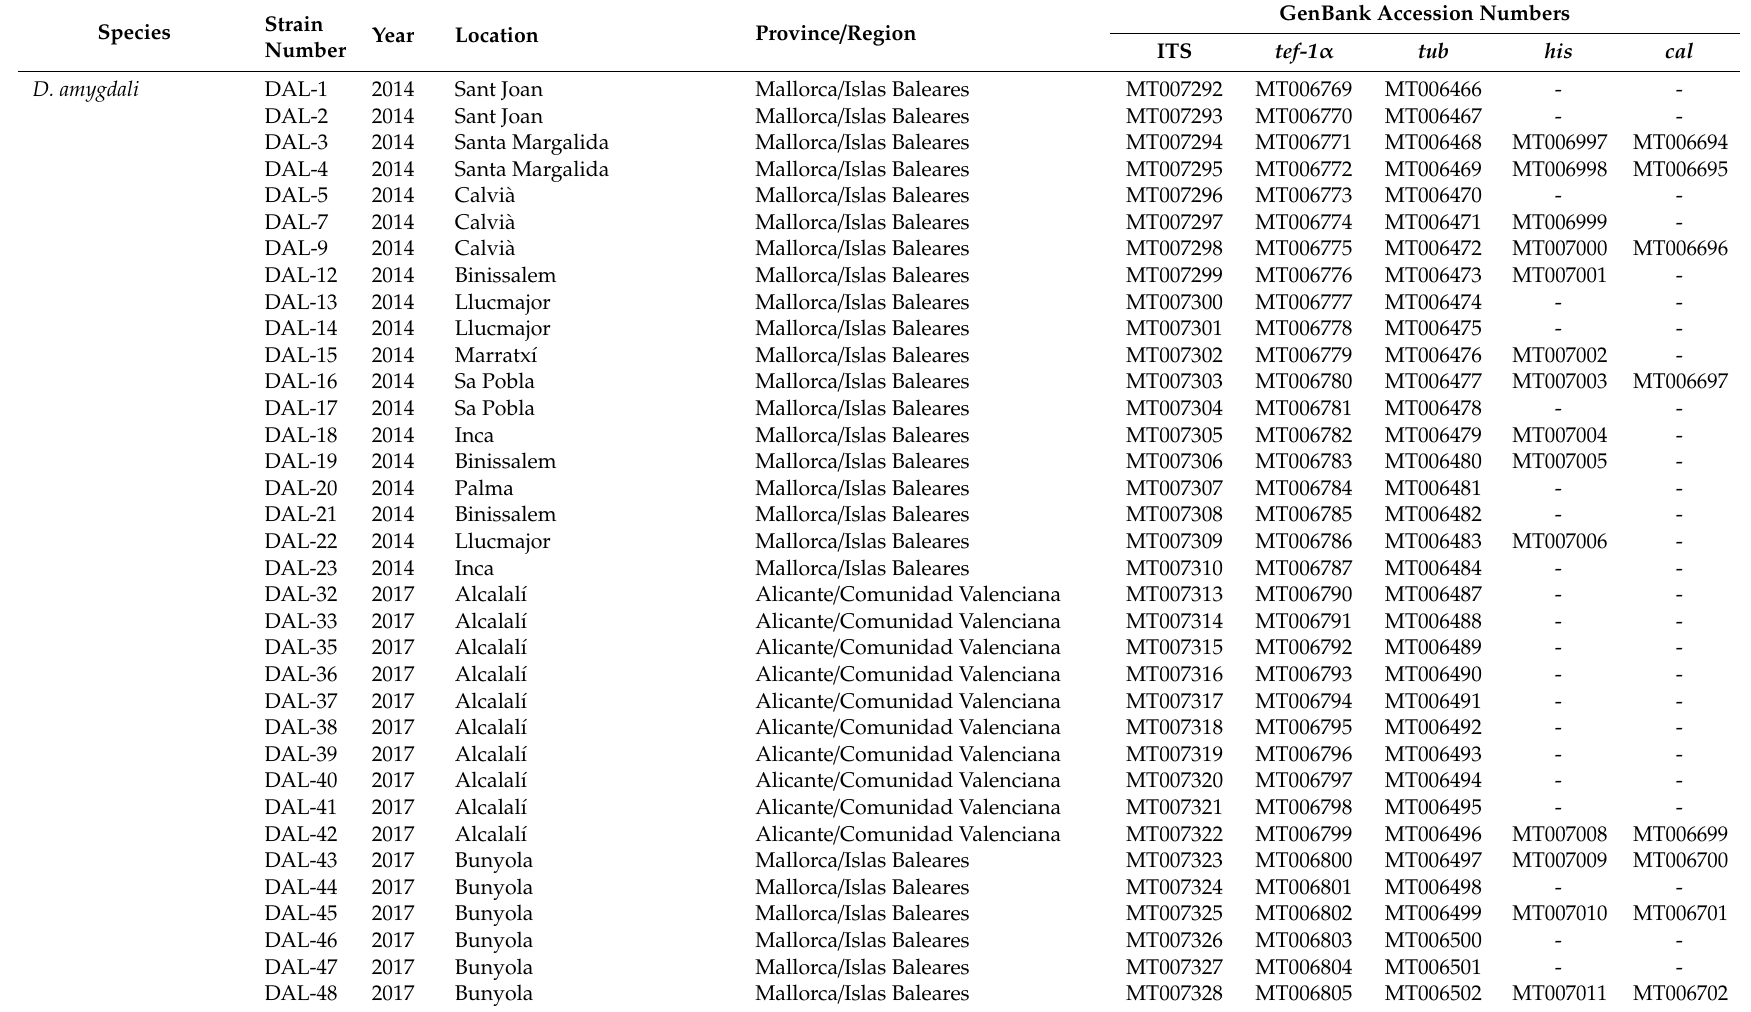
Table 1. Collection details and GenBank accession numbers of isolates included in this